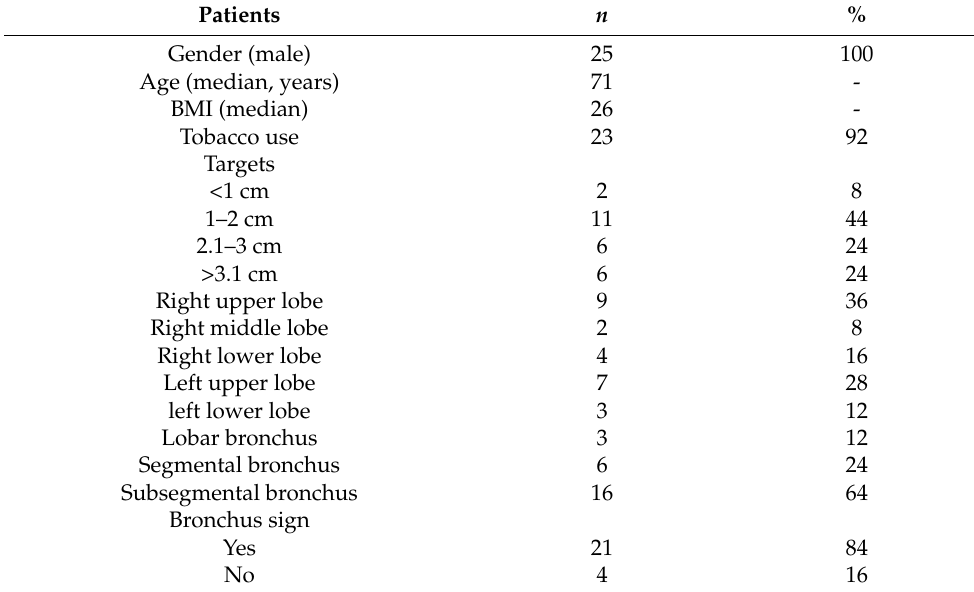
Table 1. Patient and target characteristics ( n = 25).